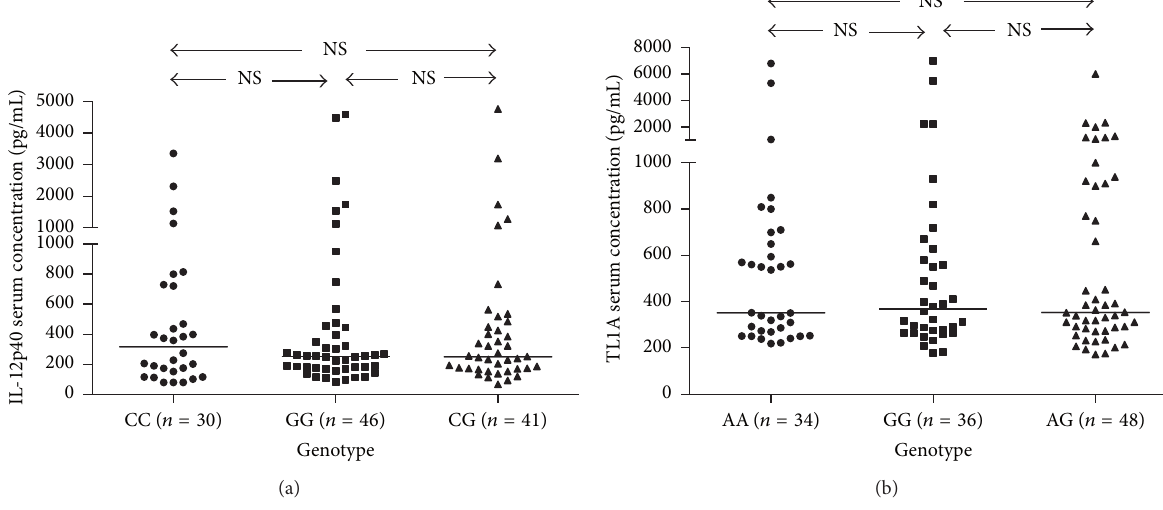
Figure 3: The relationship of polymorphism with serum IL-12p40 and TL1A levels in UC patients. (a) and (b) Among different genotype groups, no association was observed between the polymorphism and serum levels of IL-12p40 or TL1A in patients with UC ( 𝑃 > 0.05 , for both comparisons). P values refer to Mann-Whitney U test (for 2-group comparison) and Kruskal-Wallis test (more than 2 groups compared). Horizontal lines represent median values for each group and NS indicate no